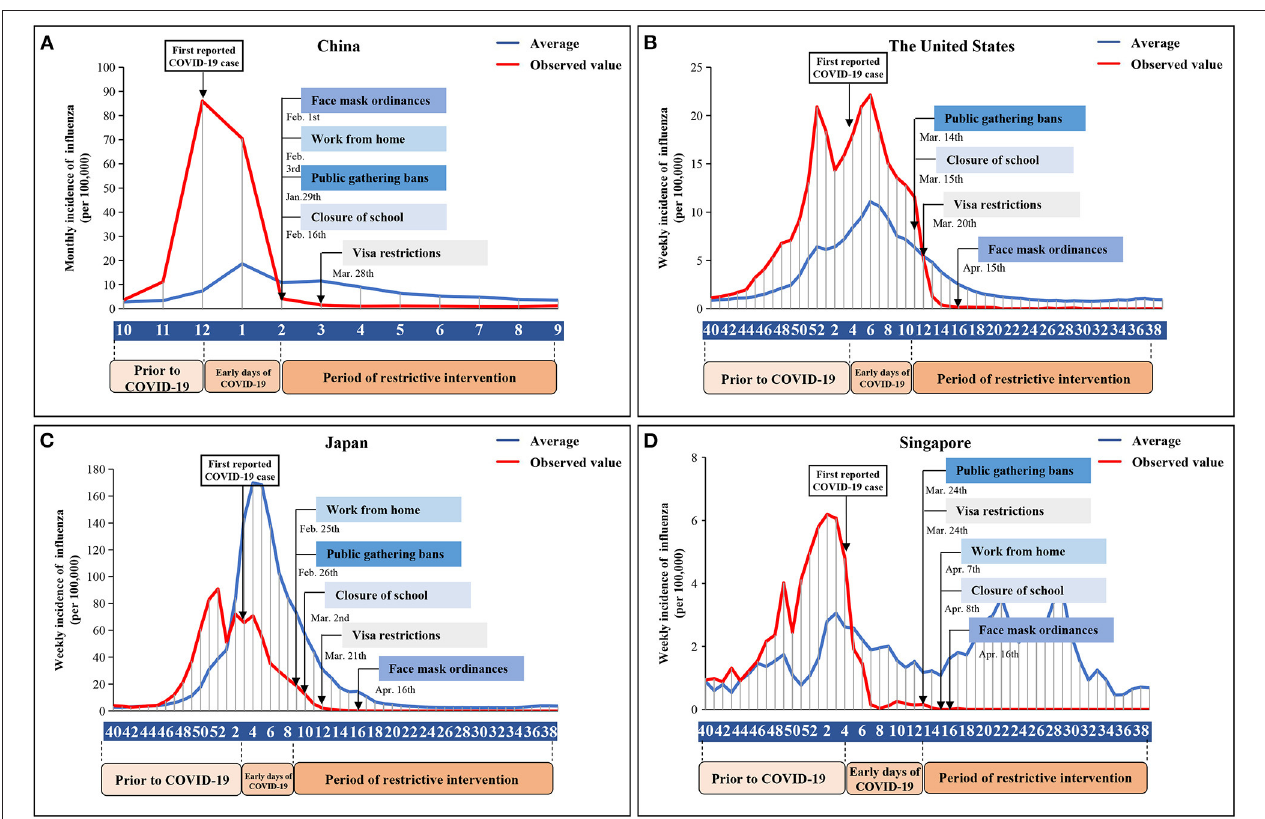
FIGURE 2 | Incidence of influenza during the 2019–2020 season (red line) compared with the average from corresponding periods in the four preceding epidemiologic years (blue line). (A) China. (B) The United States. (C) Japan. (D) Singapore.